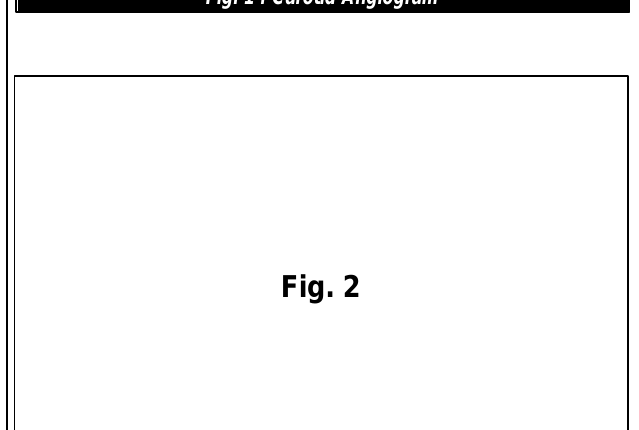
DISCUSSION Schwannomas of the head and neck are uncommon tumors that arise from cranial, peripheral or autonomic nerves. 1 They are more common in males. Thirty five percent of them occur in the neck region, most common site being the parapharyngeal space. 2 Neurogenic tumors are the most common tumors of parapharyngeal space (PPS) Schwannomas are benign tumors of neural source produced from Schwann cells 3 Fig. 1 : Carotid Angiogram